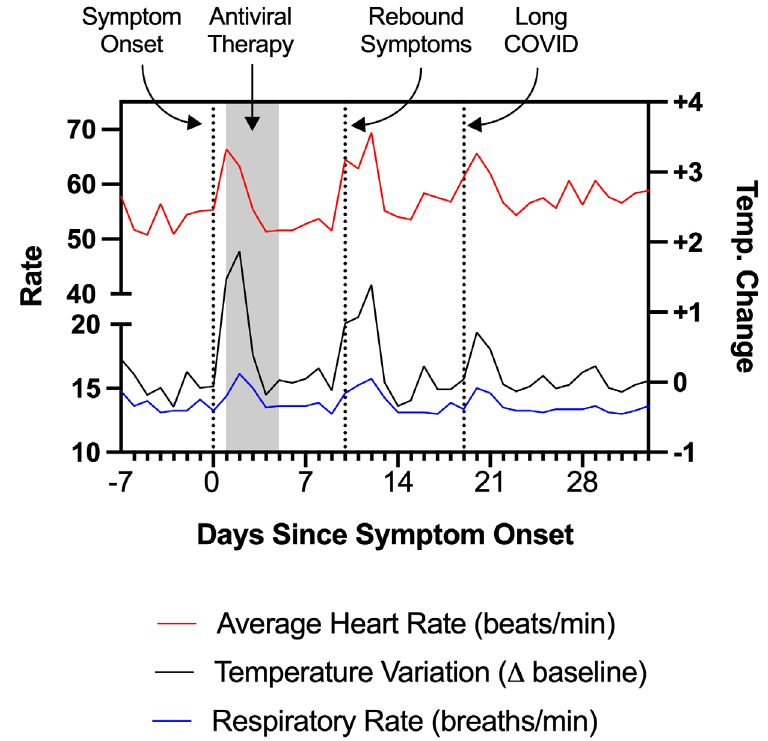
Figure 1. Physiologic measurements recorded by a personal fitness device used by Patient 1, showing rebound tachycardia, tachypnea, and elevated body temperature coinciding with completion of antiviral therapy. The individual subsequently developed additional symptoms which have persisted, consistent with Long